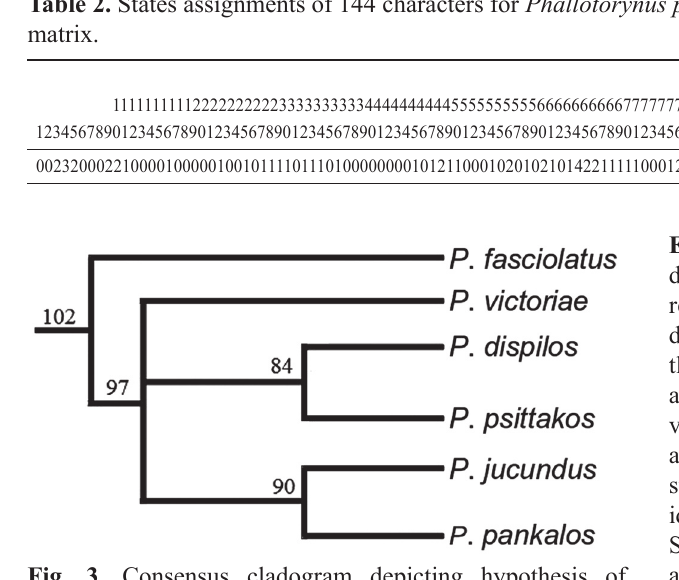
Fig. 3 . Consensus cladogram depicting hypothesis of phylogenetic relationships among Phallotorynus species.